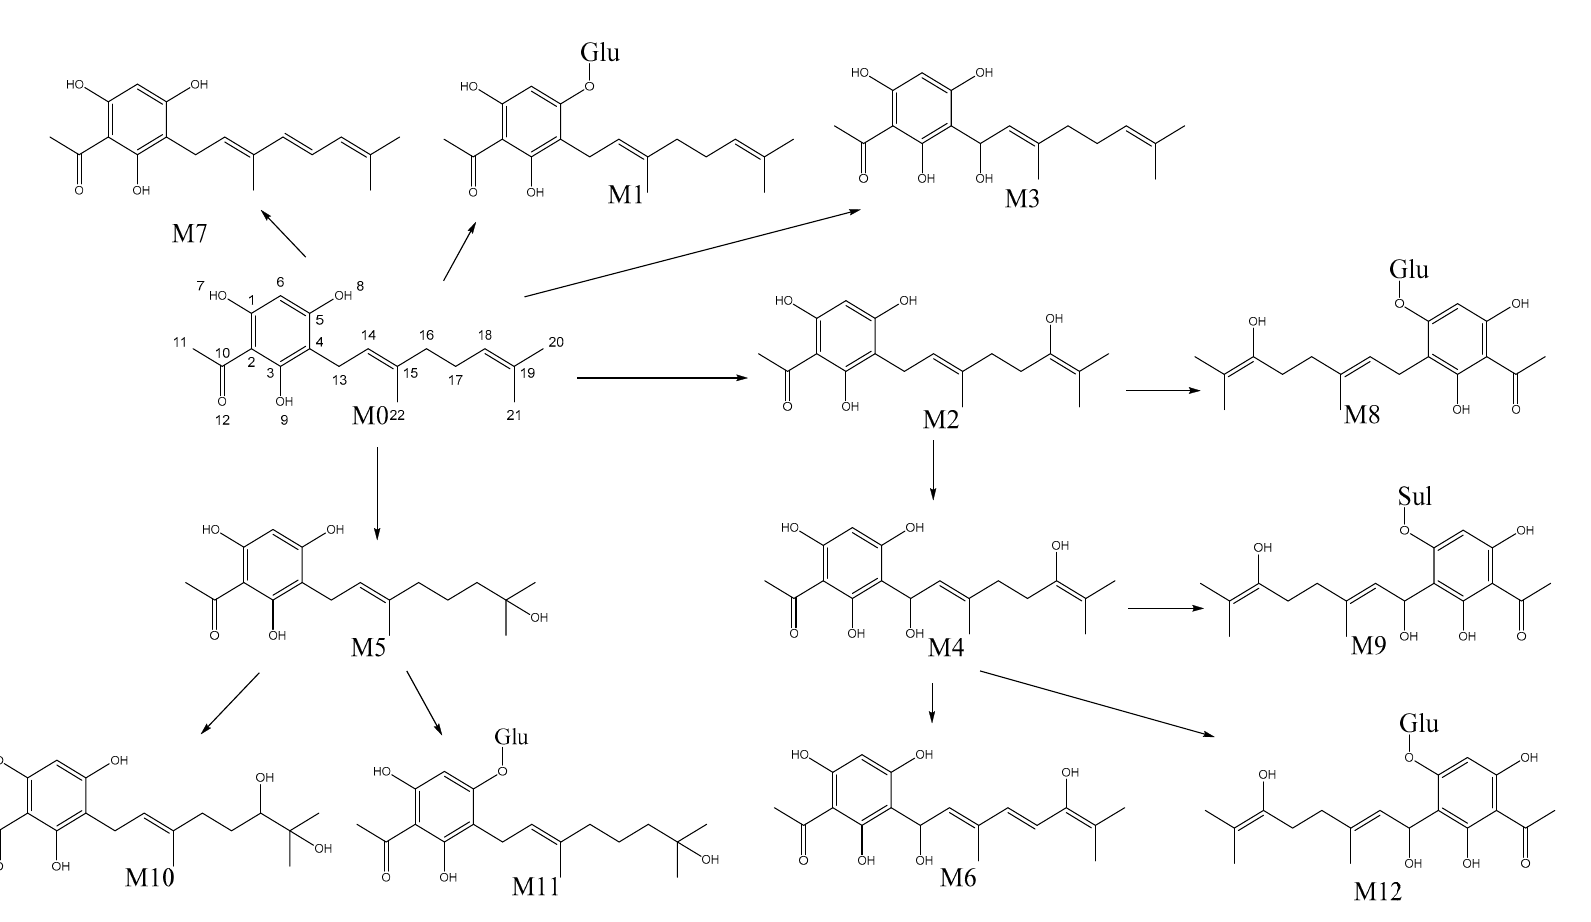
Figure 3. Proposed metabolism pathways of tHGA in rats.